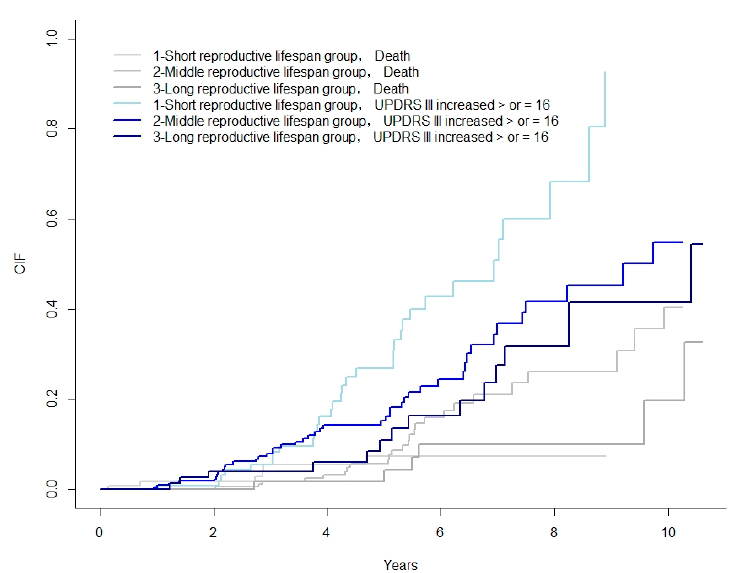
Figure 2. CIF for PD patients among different reproductive life span groups. Note: CIF, cumulative incidence functions; UPDRS, Unified Parkinson’s Disease Rating Scale.